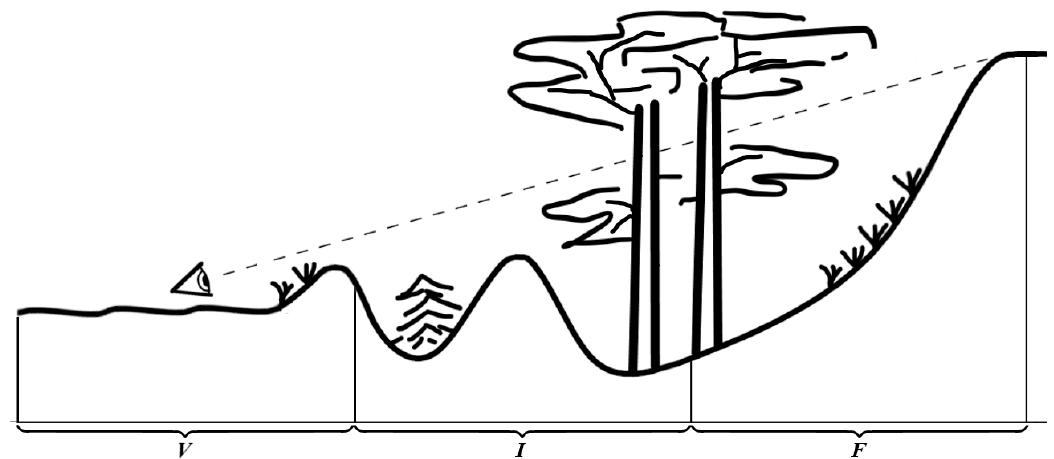
Figure 3. The principal scheme of the short-range viewshed comprising the viewpoint raster cell ( V ), the immediate viewshed raster cell ( I ) and the foreground viewshed raster cell ( F ). (Drawn by Arvydas Urbis).